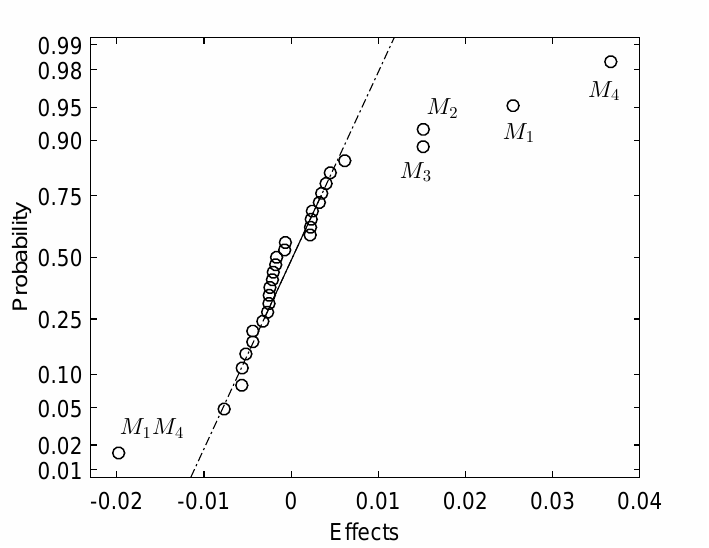
Figure 8. Normal probability plots for stage I showing effects on efficiency (total to